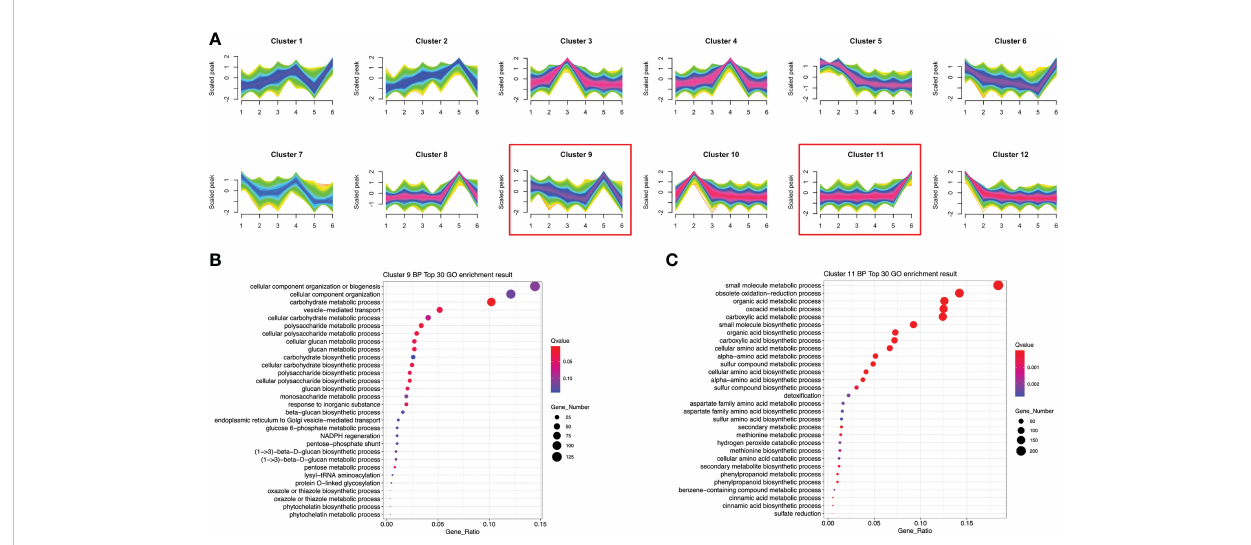
FIGURE 6 Temporal and functional analysis of differentially expressed transcripts (DETs) among rhizomes from P. sibiricum at different growth stages. (A) The 12 clusters of DETs showing differential expression patterns in different groups of rhizomes. (B) GO enrichment analysis of DETs in cluster 9. (C) GO enrichment analysis of DETs in cluster 11. In (B) and (C) , the color of the dot is determined by the q-value of enrichment analysis, and the size of dot if determined by the number of DETs in each GO